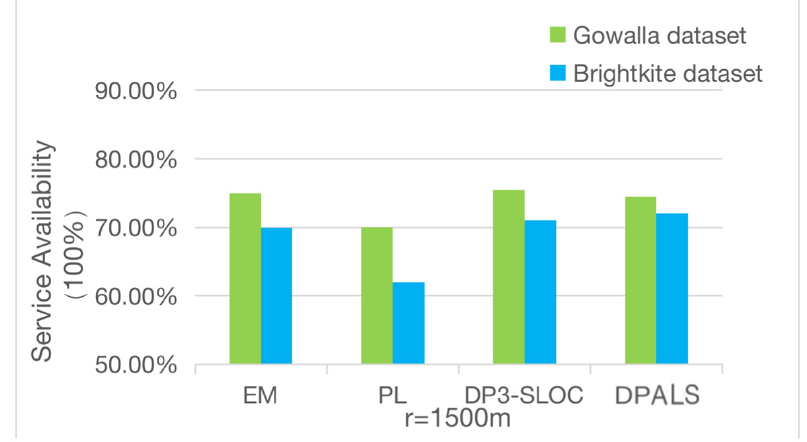
Figure 7. Comparison of service quality at r = 1500 m.